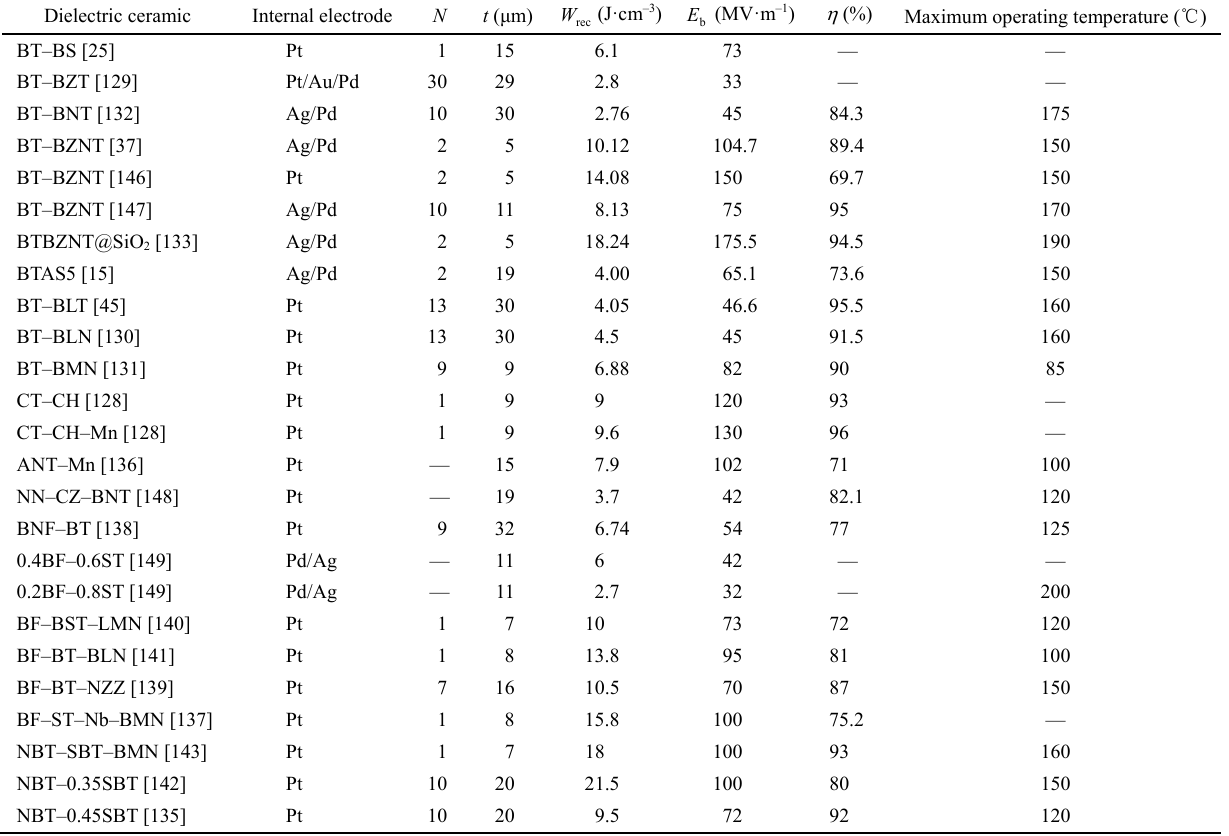
Table 8 Energy-storage performance of various